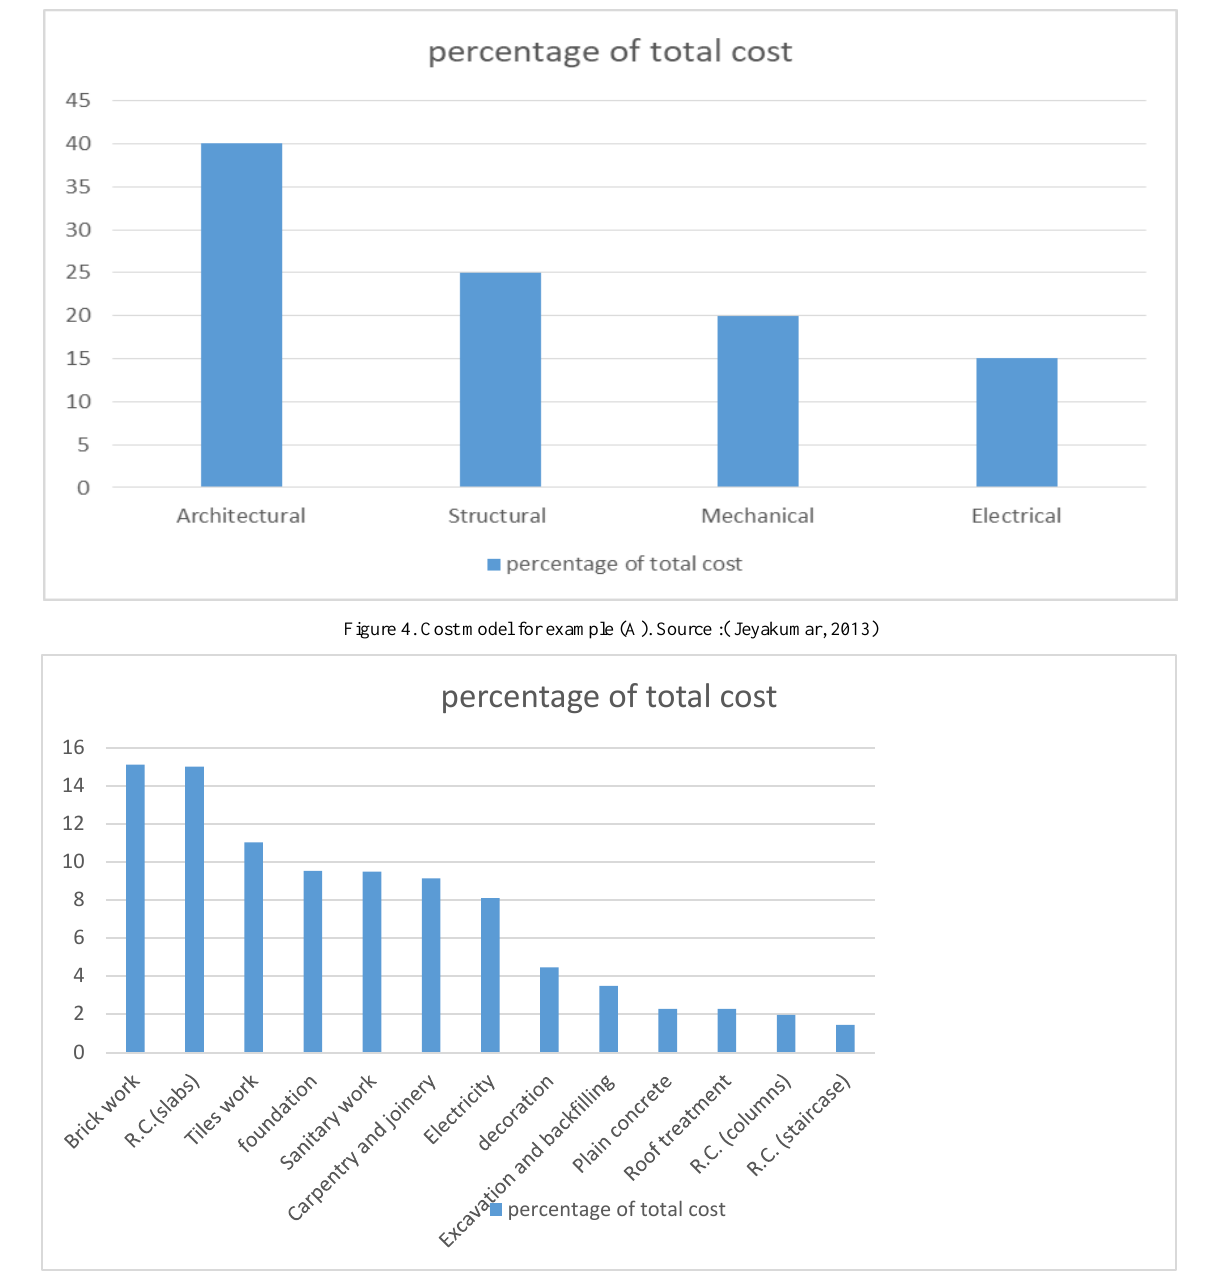
Figure 5. Cost model for example (B). Source: (Bashir,